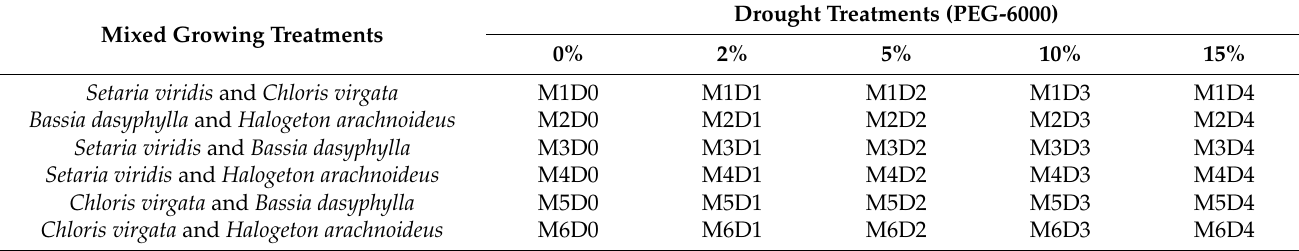
Table 1. Treatments of the